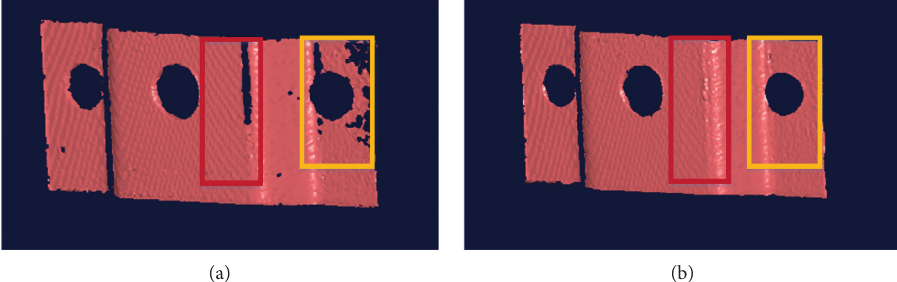
Figure 12: Experimental results of the 3D reconstruction with reflection coefficient from 0.40 to 0.50: (a) traditional phase-shifted method; (b) our method.